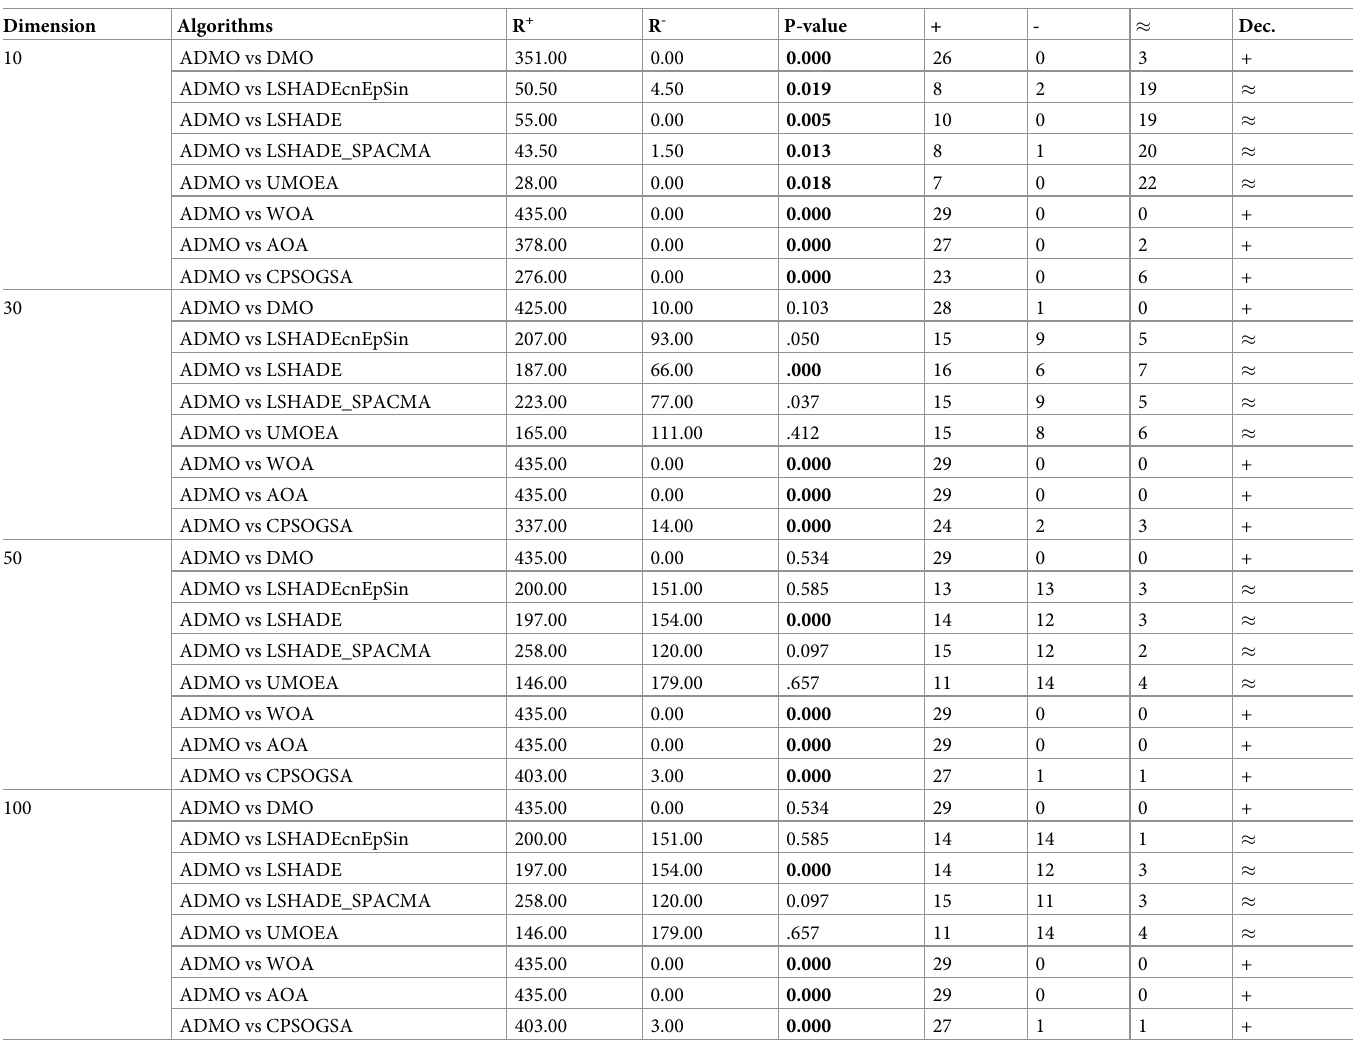
Table 15. Comparative results of Wilcoxon’s test for 10D, 30D, 50D and 100D benchmark functions.